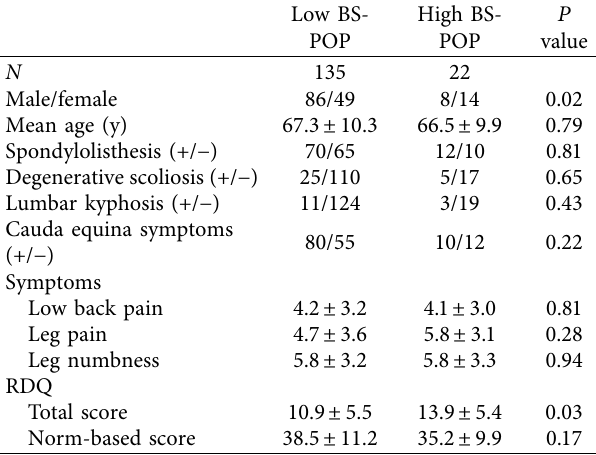
Table 1: Preoperative demographic data, NRS symptom scores, and RDQ